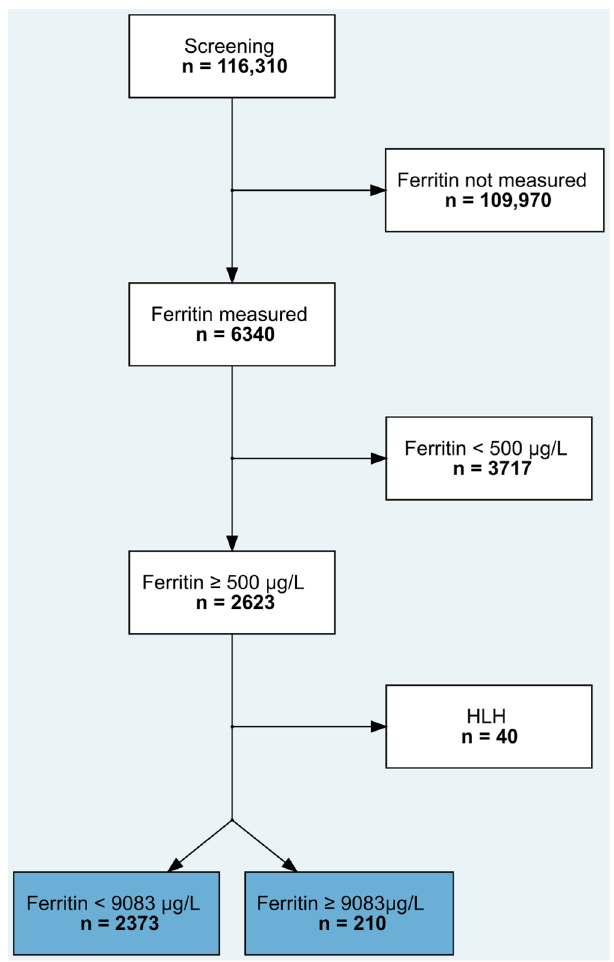
Figure 1. Consort flow diagram. HLH, hemophagocytic lymphohistiocytosis.